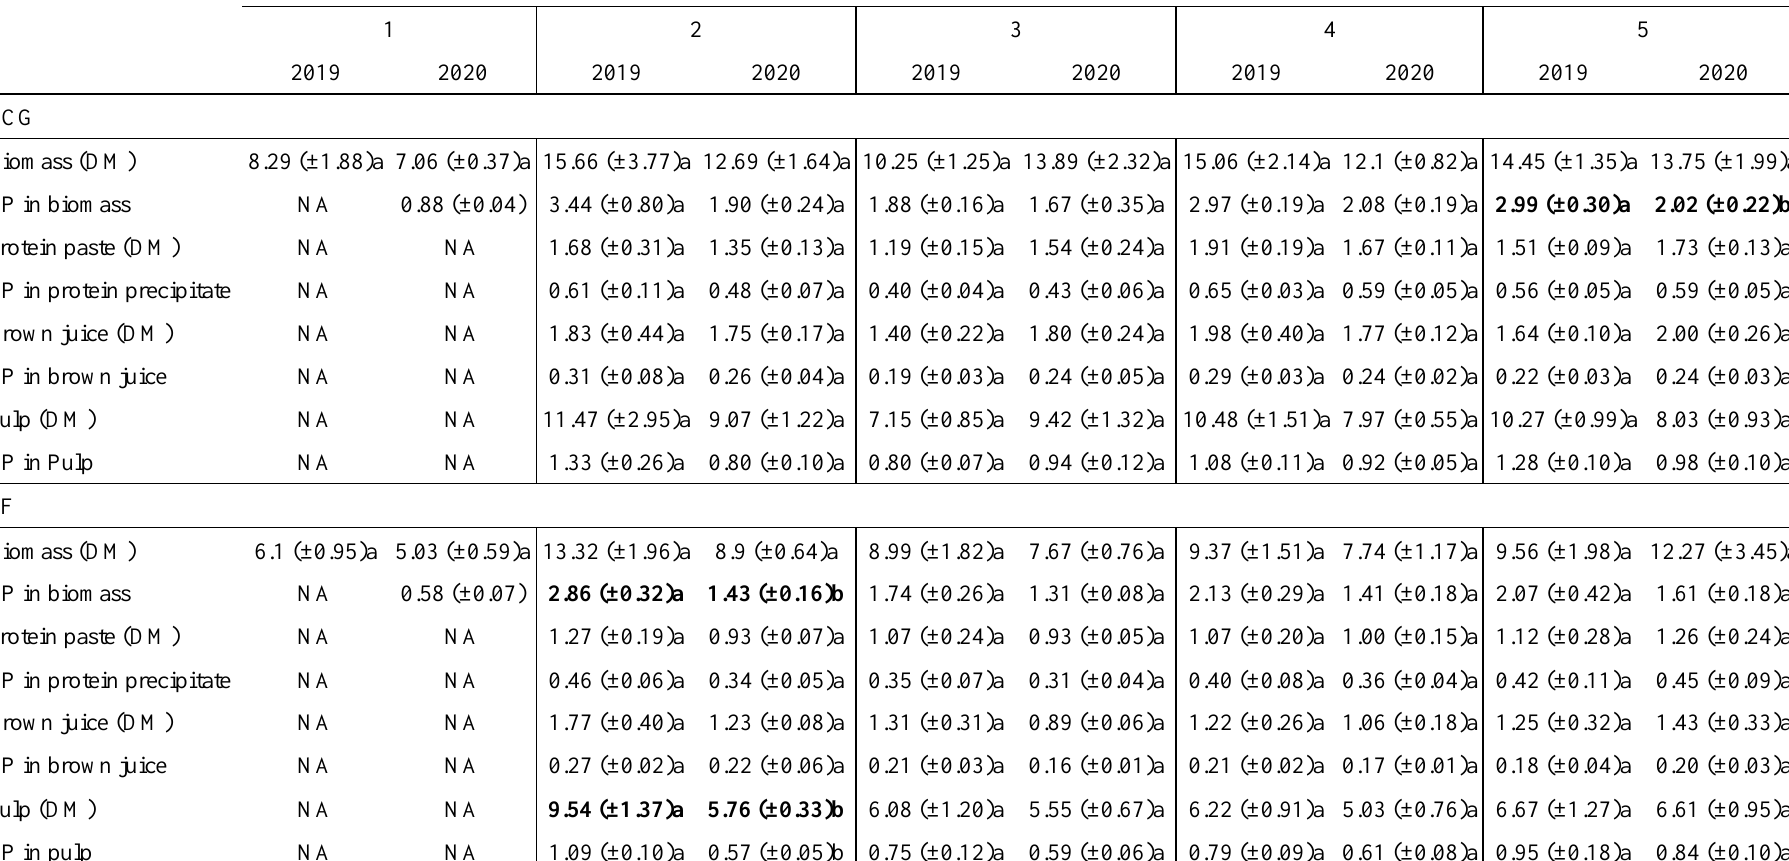
Table 1. Annual cumulative yields for dry biomass and all fractions resulting from green biorefining, including the respective crude protein (CP) yields, for Phalaris arundinacea (RCG) and Festuca arundinacea (TF) under harvest frequencies of 1 to 5 annual cuts, and for both assessed years. All values in t ha -1 yr -1 (as dry matter (DM) for biomass and biorefinery fractions). Standard error is given in brackets. Letters indicate differences between means of species and harvest for both years, where treatments with the same letter are not significantly different. Bold type indicates the (three) significant differences. Values for 2019 from Nielsen et al . (2021). Missing data (NA = not available) could not be determined due to technical difficulties. Values for 2019 from Nielsen et al .